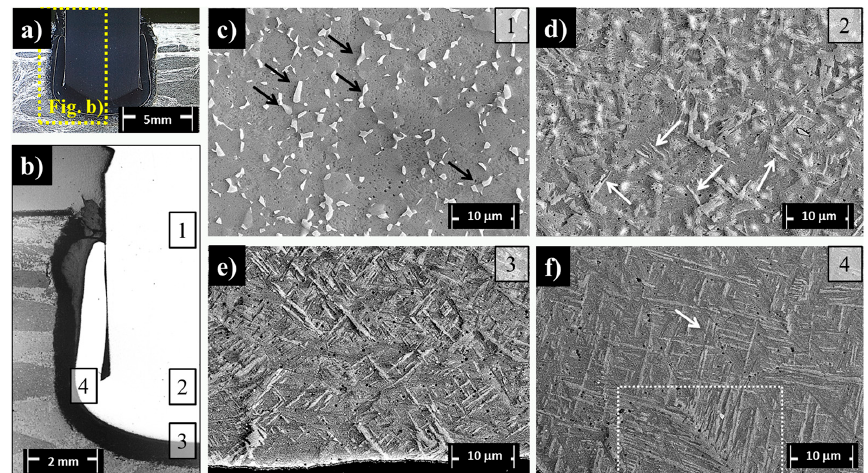
Figure 11. ( a ) Full cross-section view of a typical Ti-6Al-4V/GF-P joint; ( b ) detailed view of half section of the joint in ( a ), where the microstructural analysis was performed; regions (1–4) are detailed in ( c – f ) figures, respectively (HEI joining conditions: rotational speed = 9000 rpm, friction time = 1.2 s and forging time = 1.2 s). In ( f ), Widmanstätten and martensitic structures are depicted by a dash-line rectangle and an arrow, respectively. Table 5. Grain sizes and aspect ratios of different microstructures developed through the rivet during FricRiveting.